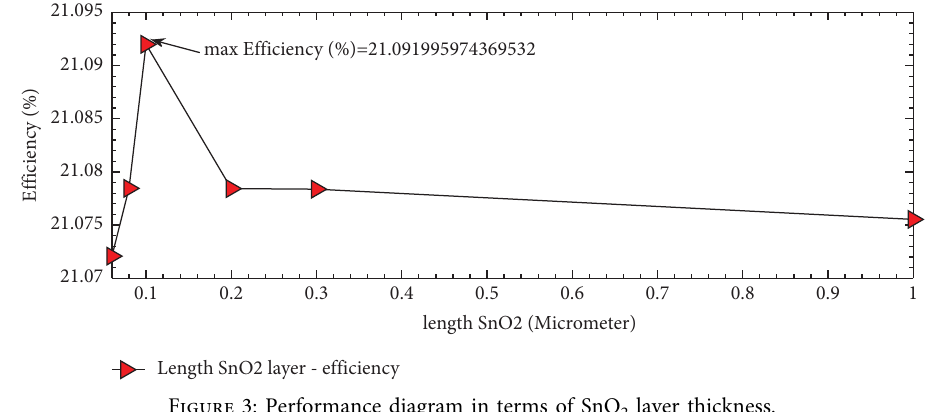
2 layer thickness.